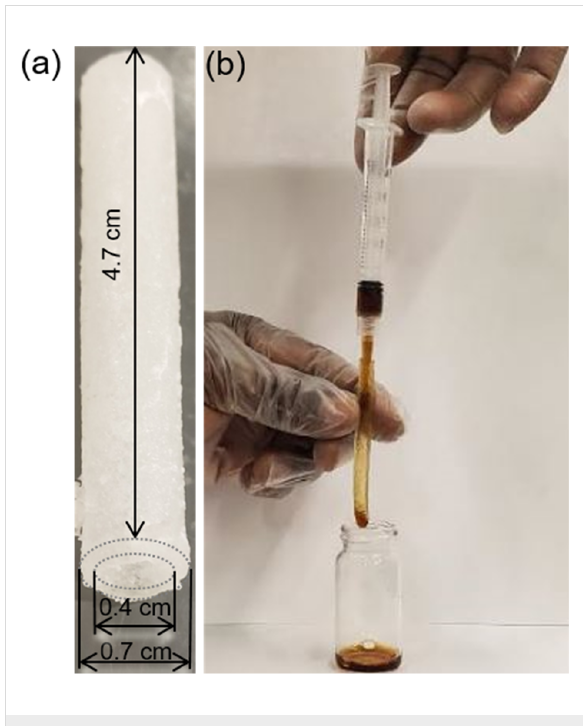
Figure 6: Experimental investigation of NP transport through soft hydrogel flow paths. (a) Representative hydrogel channel and (b) image showing a model flow